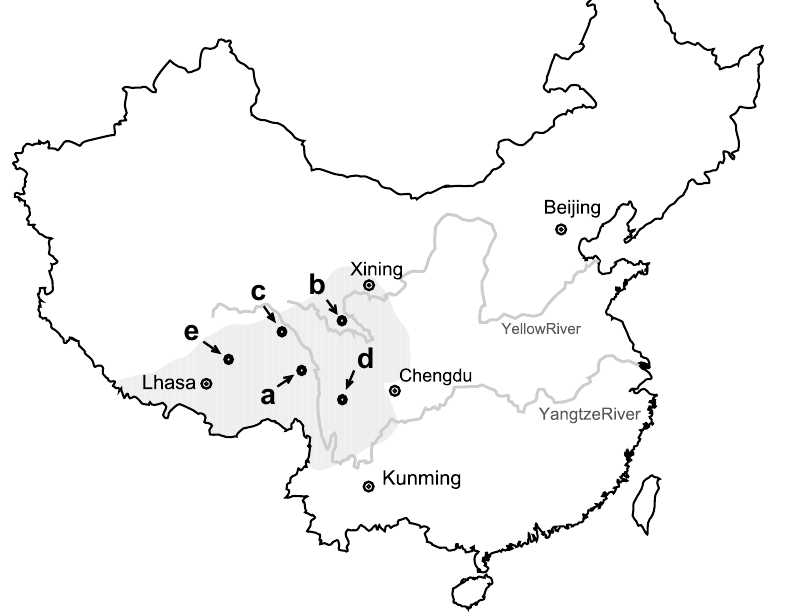
Figure 1. Schematic map illustrating the sampling sites in the Qinghai-Tibetan Plateau and its adjacent high- altitude areas. ( a ), Changdu; ( b ), Guoluo; ( c ), Haxiu; ( d ), Litang; and ( e ), Naqu. The map was modified from Guo, L. X. et al . 5 (Copyright © 2011 Elsevier Masson SAS. All rights reserved.) using CorelDraw X4 (Corel Corporation, Ontario,